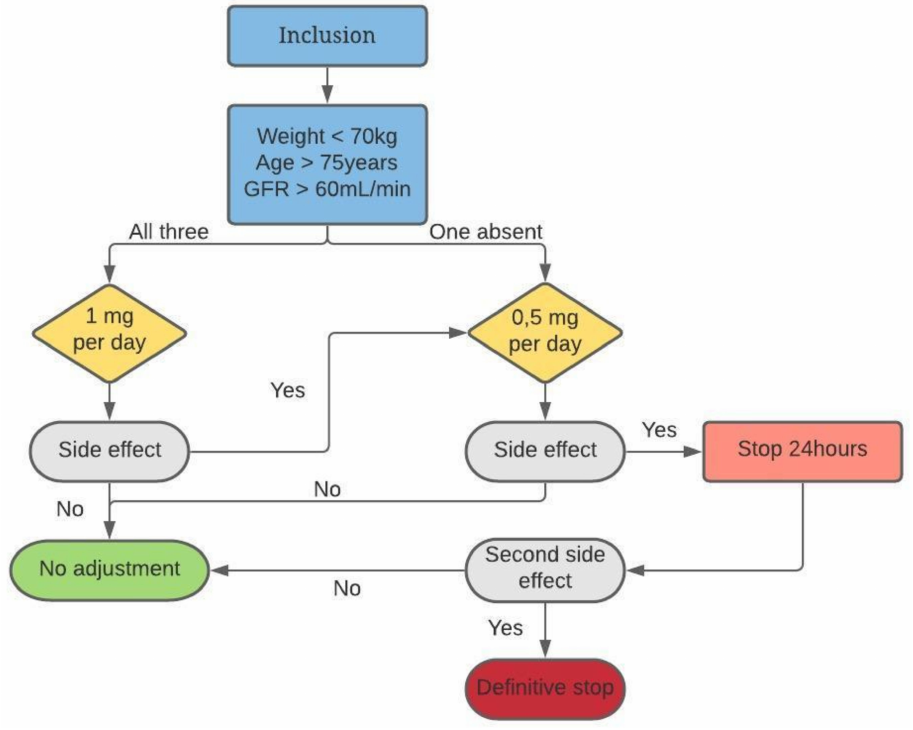
Figure 1. Algorithm of dose adjustment in case of side effects. GFR: Glomerular Filtration Rate. Drug safety will be assessed by an evaluation of types, frequencies, severities and du- ration of any reported adverse events. Patients will be monitored for signs and symptoms of drug